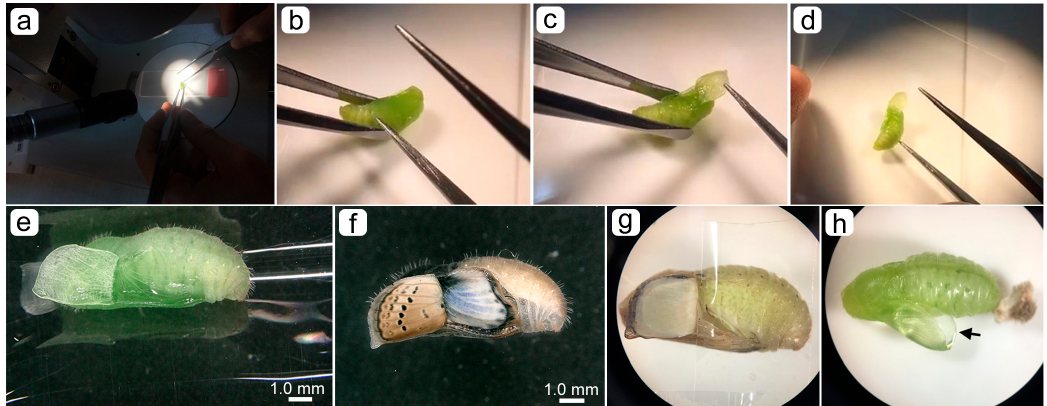
Figure A2. Surgical procedures. See also Figure 2; Video S1. ( a ) Overall view of surgical operation. ( b ) First step: the forewing margin is picked up. ( c ) Second step: the forewing is lifted from the margin to the base. ( d ) Third step: a piece of cover glass is placed on the lifted wings. ( e ) An